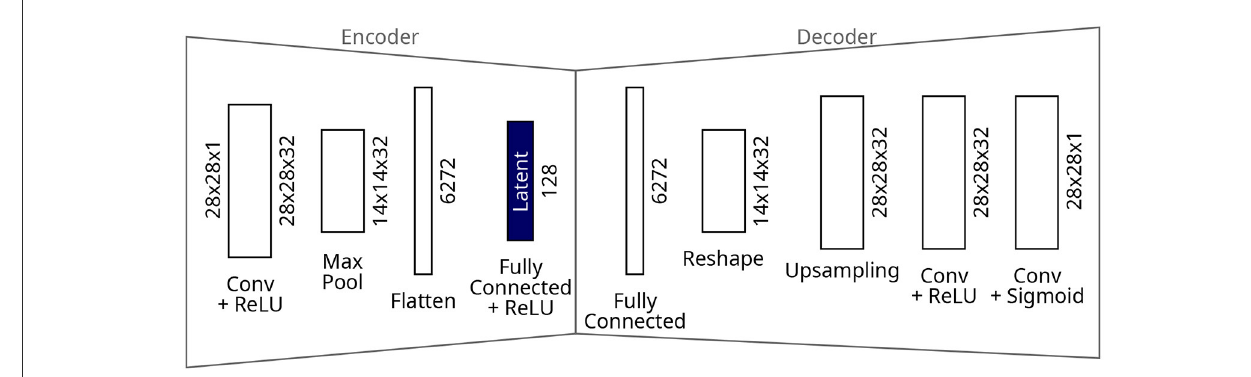
FIGURE3 Architecture of the autoencoder for the MNIST dataset.